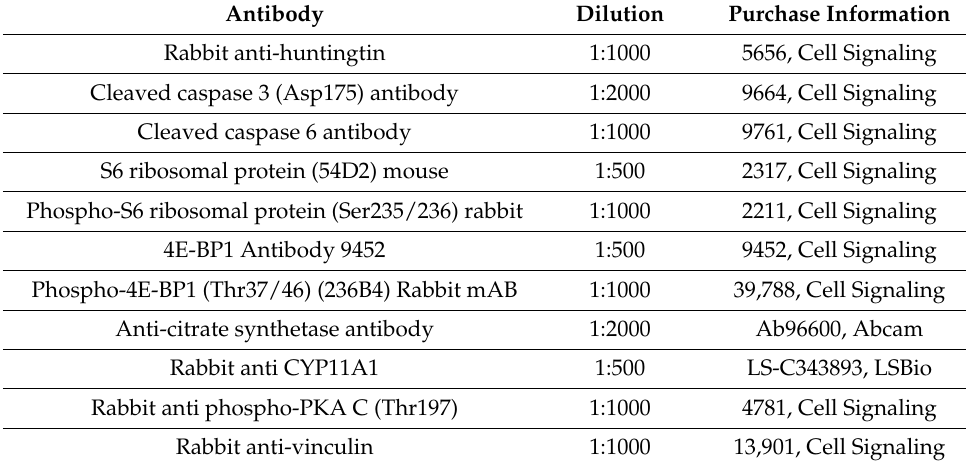
Table A1. Summary of antibody dilution and purchase information.